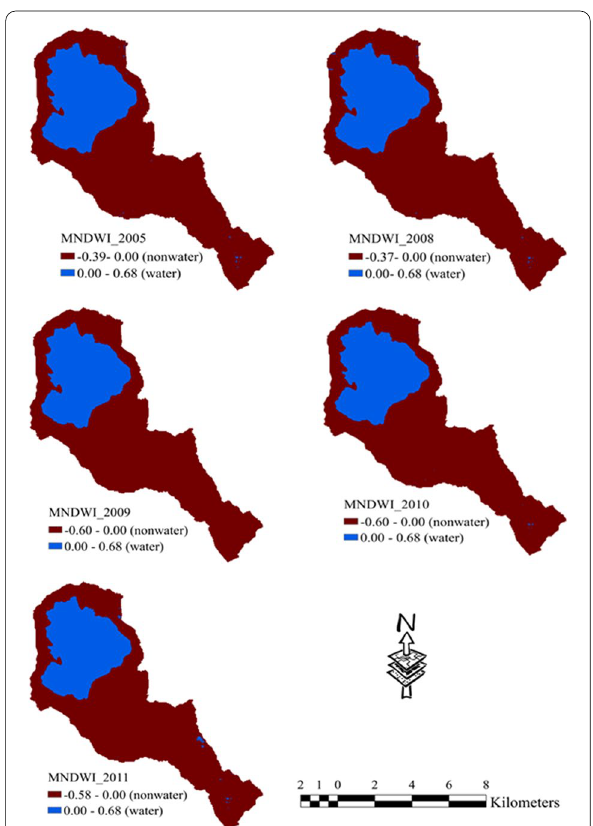
Fig. 6 Maps of water and nonwater features extracted from Landsat 7 ETM (2005 and 2008) and Landsat 5 TM (2009–2011) using the + MNDWI